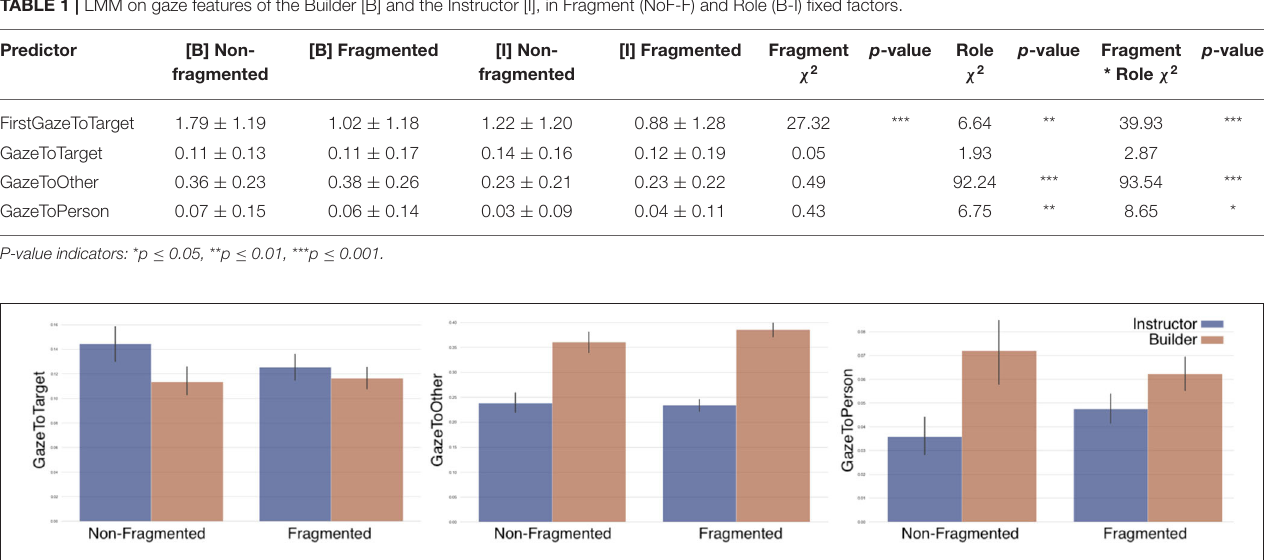
TABLE 1 | LMM on gaze features of the Builder [B] and the Instructor [I], in Fragment (NoF-F) and Role (B-I) fixed factors.